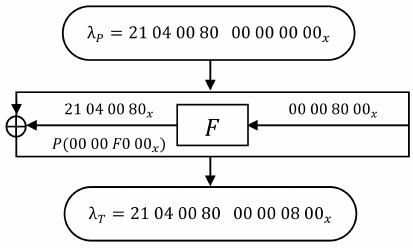
Figure 4: The Best Single-Round Linear Approximation of DES with Bias − 20 / 64 ( λ 1 ). The subsets of bits participating in the parities are denoted as bit masks.